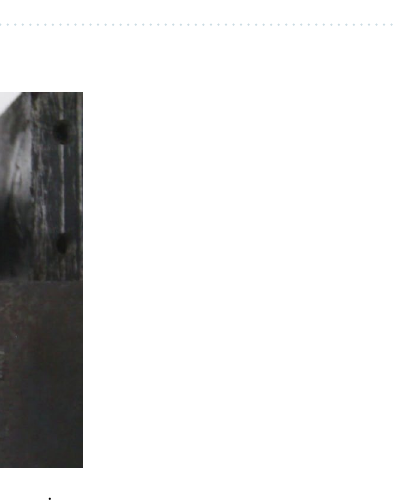
Figure 41. Photograph of a specimen showing fractures